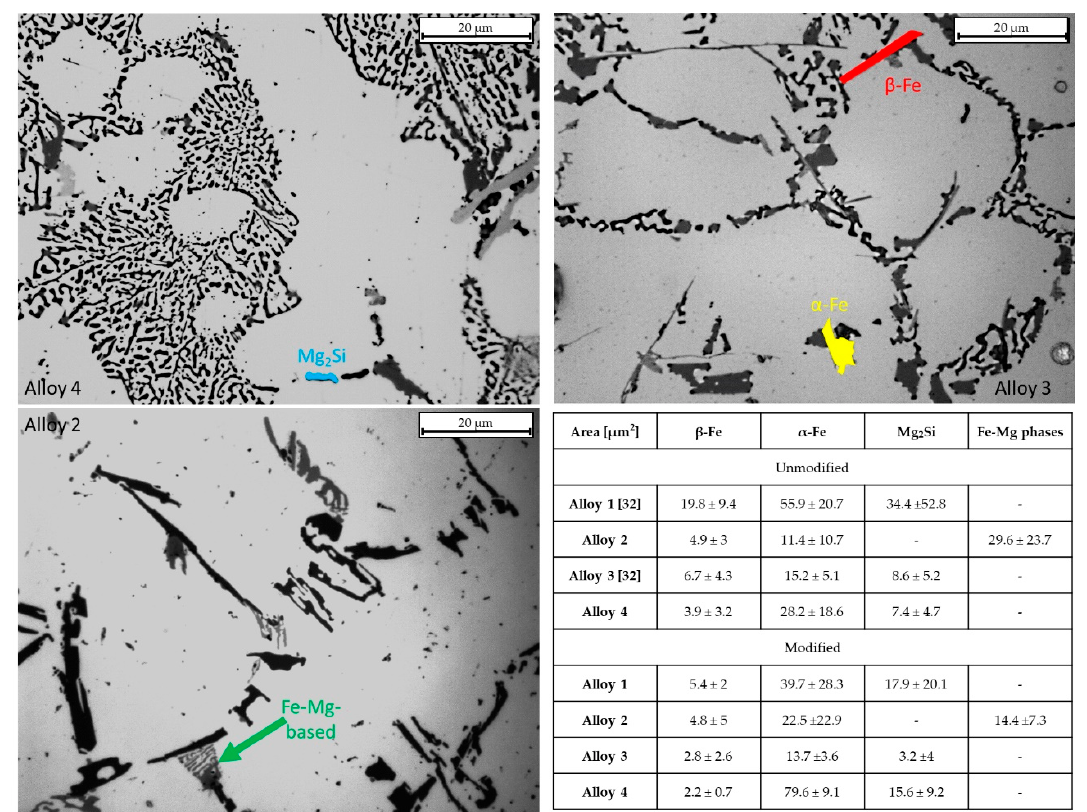
Figure 7. Intermetallics measured for each alloy. Intermetallic measurements are evidenced in the micrographs by different colors—the table shows the area occupied for each intermetallic phase. Data for the α -Fe and β -Fe in the unmodified condition for alloys 1 and 3 refer to previous work [32].